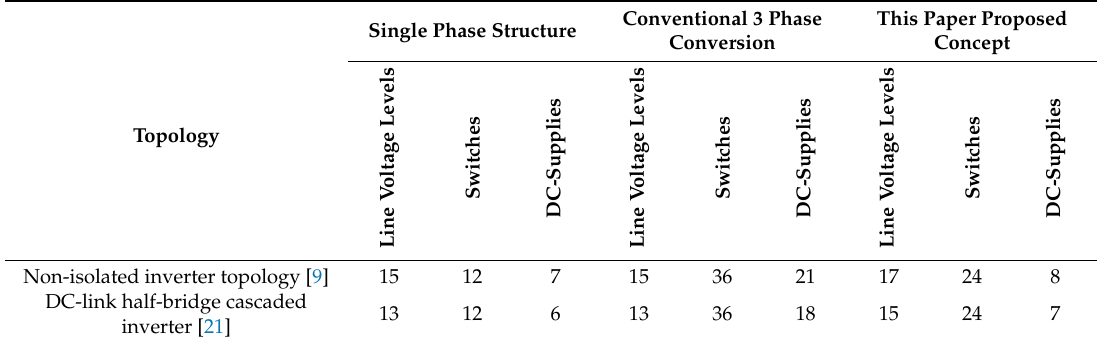
Table 1. Comparison between three-phase conversion of a single-phase structure using conventional methods and proposed concept in this